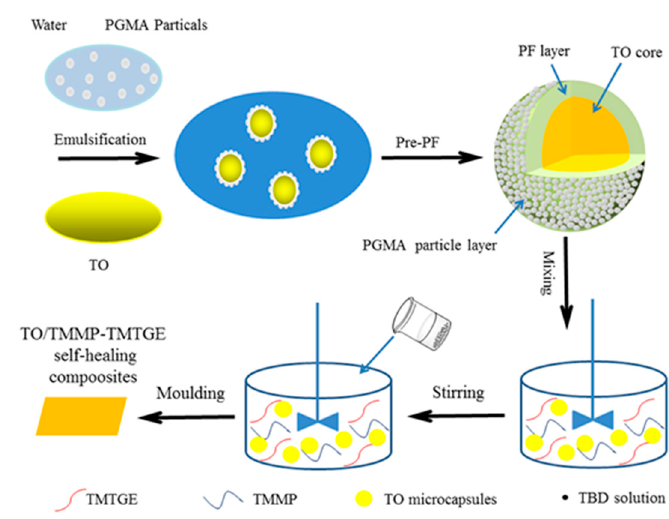
Figure 1. Preparation process of TO/TMMP-TMTGE self-healing composite.